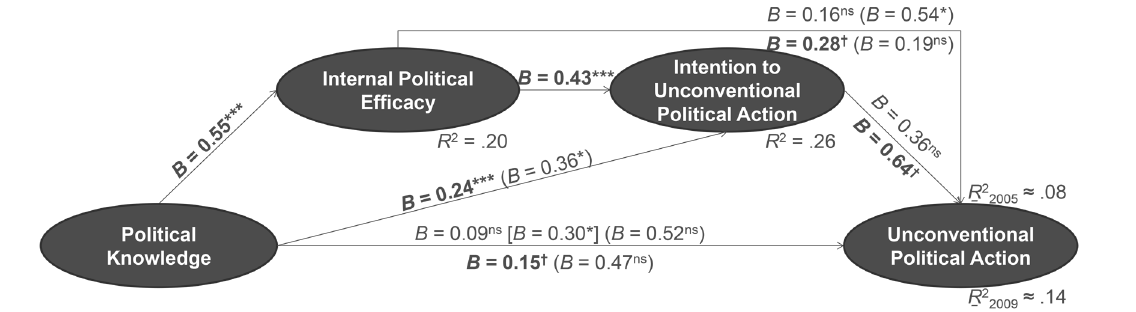
Figure 3. Prediction of unconventional political participation by political knowledge, sequentially mediated through internal political efficacy and intention to participate in unconventional political action (effects on unconventional participation between 2002 and 2005 above lines; effects on unconventional participation between 2005 and 2009 below lines; n = 2,353). Note. Unstandardized regression weights; direct effects in mediated regressions in round parentheses; indirect effect of political knowledge by intention to participate on actual behaviour in squared